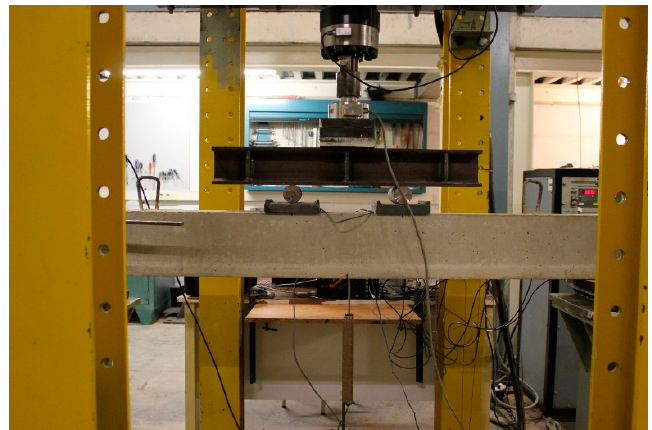
Figure 3. Experimental setup.